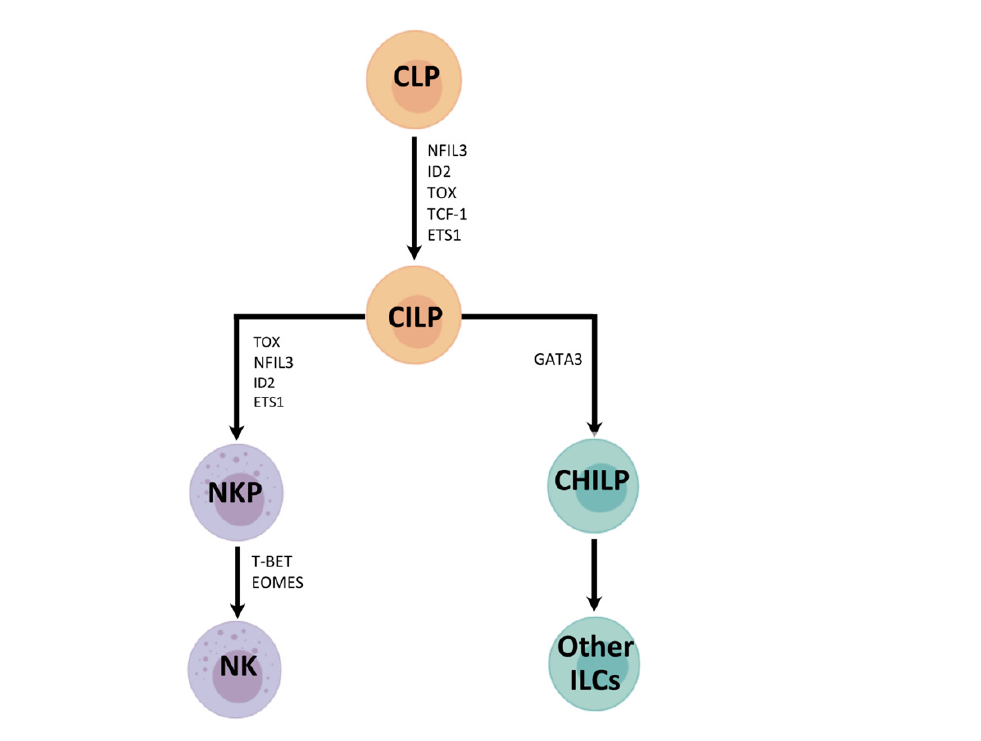
Figure 1. NK cell development with summaries of the transcription factors required at each stage of differentiation [28]. NK cells originate from common lymphoid progenitors (CLPs), which differen- tiate into CILPs (common innate lymphoid progenitors). CILPs then differentiate into NK cell pre- cursors (NKP) or common helper innate lymphoid progenitors (CHILPs). The former give rise to NK cells, and the latter develops into other ILCs. NFIL3 = nuclear factor IL-3 induced; ID2 = inhibitor of DNA binding 2; TOX = thymocyte selection-associated high mobility group box protein; TCF-1 = T cell factor 1; ETS1 = avian erythroblastosis virus E26 homolog-1; GATA3 = GATA binding protein 3; T-bet = T-box transcription factor; Eomes = Eomesodermin.